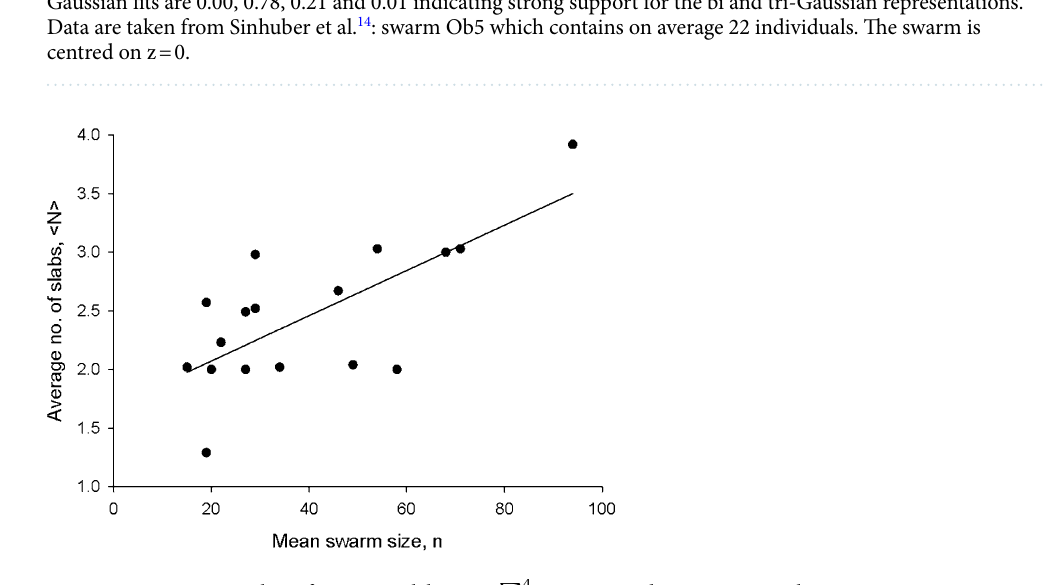
Figure 3. Average number of Gaussian slabs N population size, n. w N are the Akaike weights for best-fit profile containing N slabs. The least-squares linear regression (solid line) is added to guide the eye (R 2 = 0.50). Data are taken from Sinhuber et al. 14 . All 17 daytime